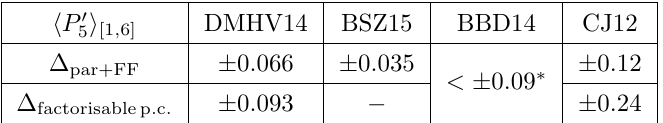
Table 8 . Uncertainties on the SM prediction for P 0 in the long bin [1 ; 6] GeV 2 : the (cid:12)rst row gives 5 the parametric and form factor uncertainty added in quadrature, the second row provides the error from factorisable power corrections. In the BBD14 case [43], only the total error size is given for nominal priors, suggesting that this number should be taken as an upper bound of the subset of errors discussed